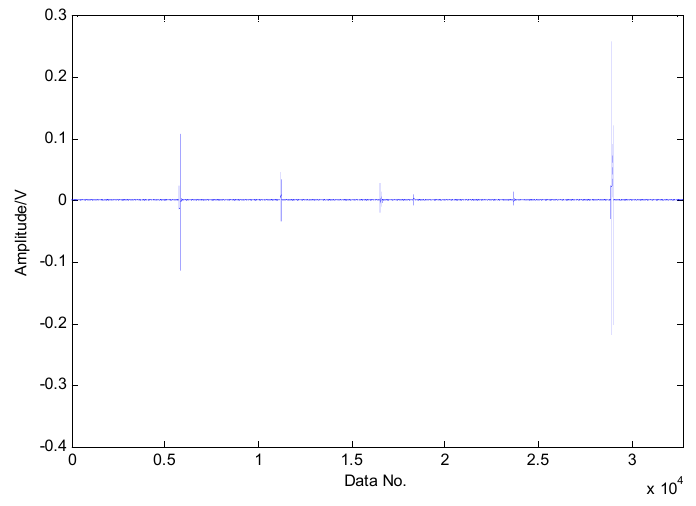
Figure 13. The transient impact component using TQWT.